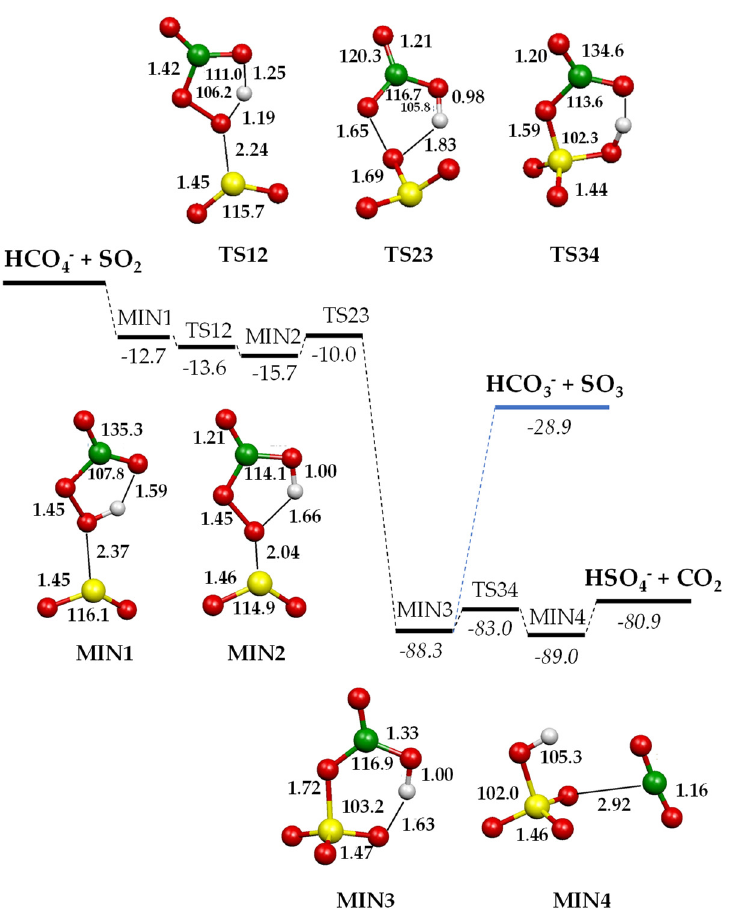
Table 2. In the following, only the CCSD(T) values will be considered.